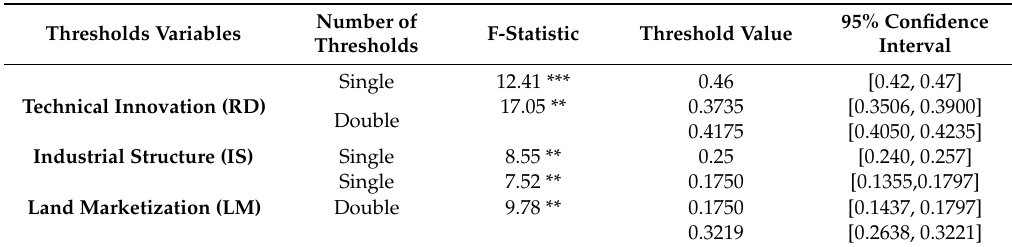
Table 4. Test on threshold e ff ects and threshold value estimation.